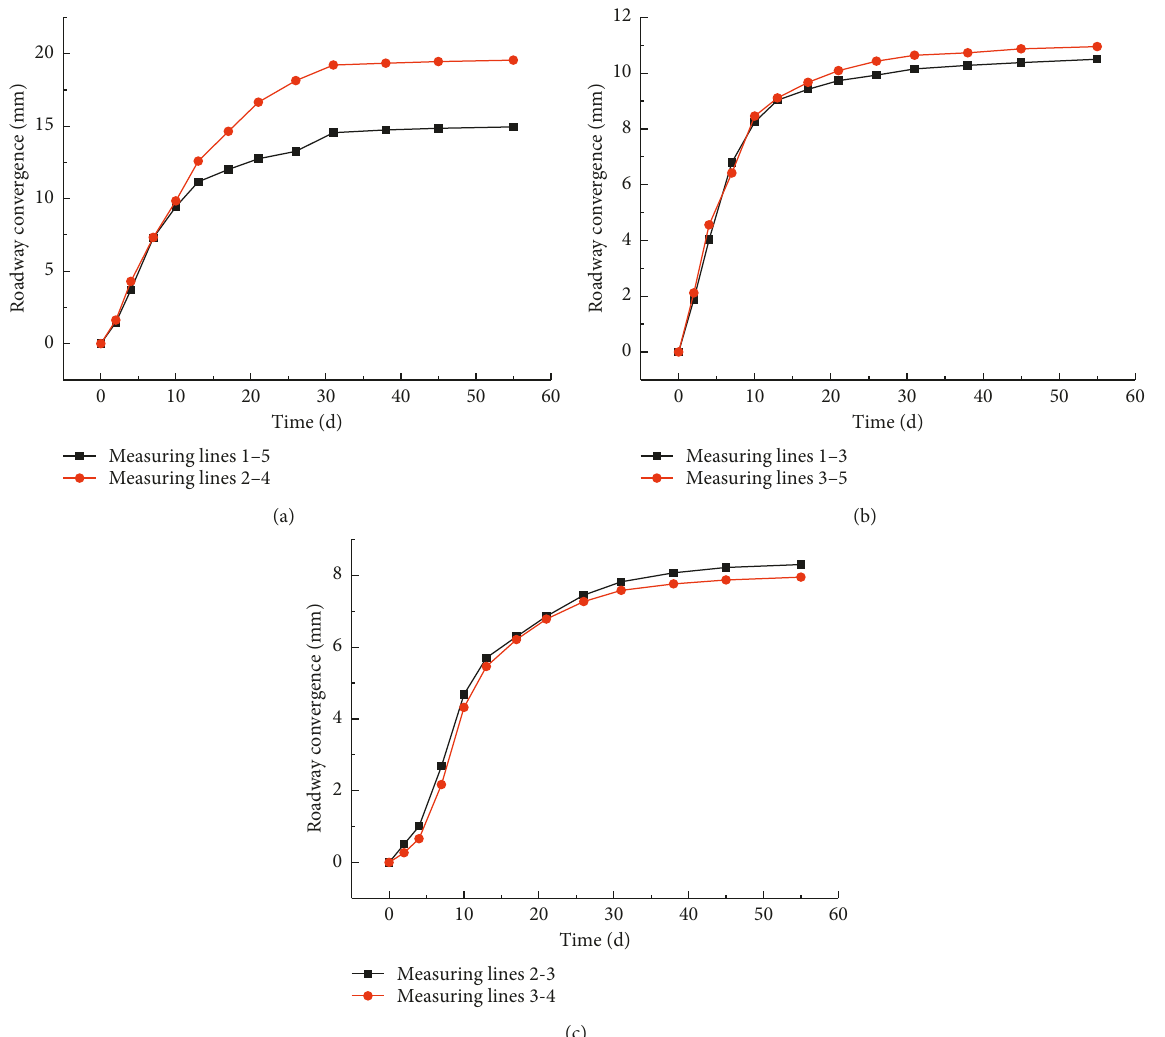
Figure 20: Roadway convergence monitoring curves of (a) lines 1–5 and lines 2–4, (b) lines 1–3 and lines 3–5, and (c) lines 2-3 and lines